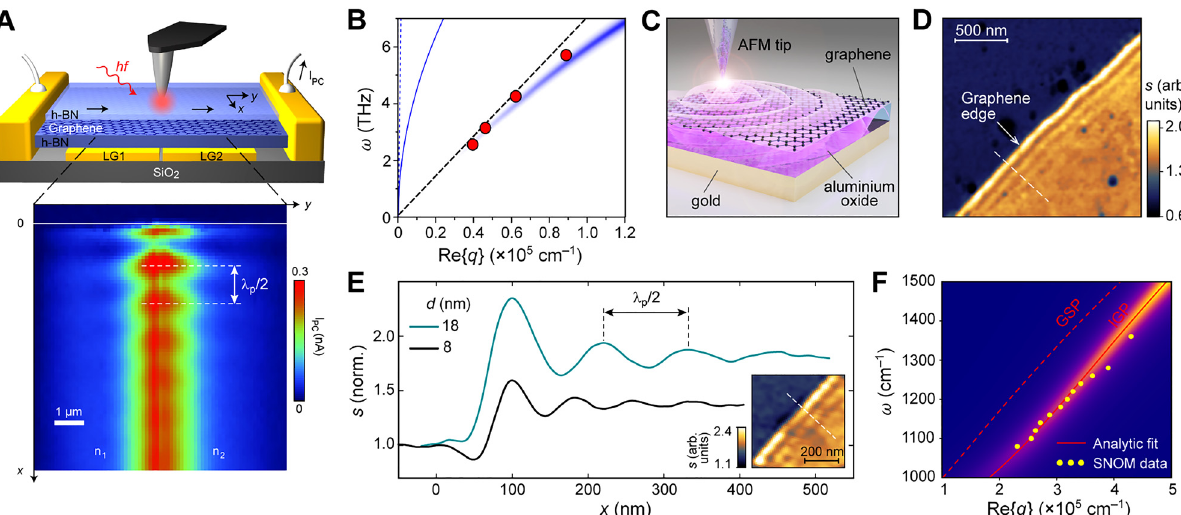
Figure 4: Near-field probing of IGPs. (A)PTEcurrent-assistednear-fieldimagingofTHzimageplasmonsingraphene:near-fieldinterferencemodulatesthePTEcurrentgeneratedat the p-n junction between the two graphene areas of different doping. (B) Dispersion of the THz IGP (data points) measured from the near-field interference fringes shown in (A). The blue color plot shows the calculated dispersion of IGP in an air/hBN/graphene/hBN/AuPd/SiO 2 heterostructure assuming the experimental conditions, while the thin blue solid curve indicates the dispersion of GSP in free-standing graphene with the same carrier concentration. The dashed black line displays the analytical approximation of the IGP dispersion, while the dashedbluelineindicatesthelightlineinfree-space,andisnearlyindistinguishablefromthe y -axis.(A)and(B)Adaptedwithpermissionfrom [31]. Copyright 2017, Springer Nature. (C) Schematics of near- fi eld optical probing of IGPs in the gold/alumina/graphene multilayer structure; the sharp AFM tip of the s-SNOM couples to the near- fi eld of the plasmon-polaritons via scattering. (D) Near- fi eld map of the graphene edge on gold/alumina substrate, spacer thickness d = 18 nm and ω 0 = 1150 cm − 1 ; interference fringes of image plasmons are clearly visible, revealing the plasmon wavelength. (E) Interference fringes of image plasmons upon their re fl ectionatgrapheneedge,measuredinsampleswith d =18and8nm.Inset:near- fi eldmapofthegrapheneedgeinthesamplewith d =8nm. (F) Measured (data points) and calculated (color map and solid red line) dispersion of an image plasmon, presented along with that of surface graphene plasmon (dashed red line); d = 21 nm. (C) – (F) Adapted with permission from [38]. Licensed under a Creative Commons